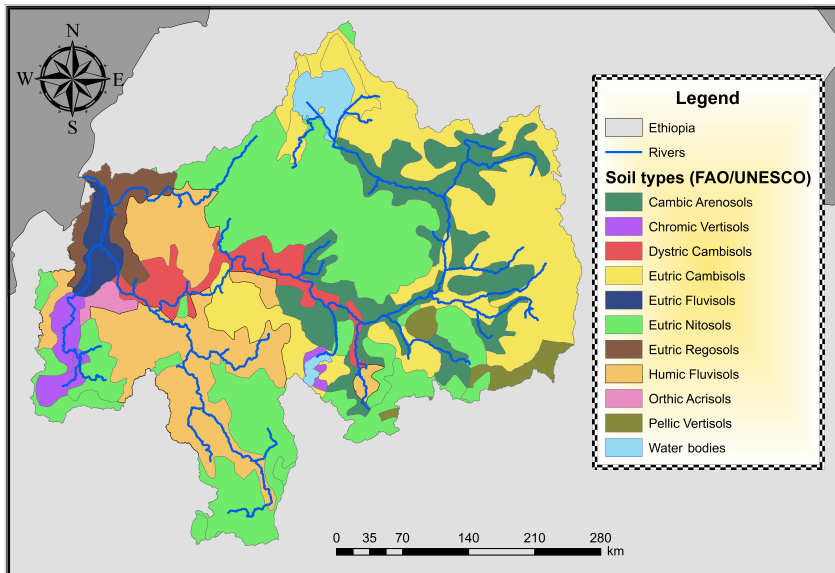
Figure 2. FAO/UNESCO soil map of the upper Blue Nile Basin.